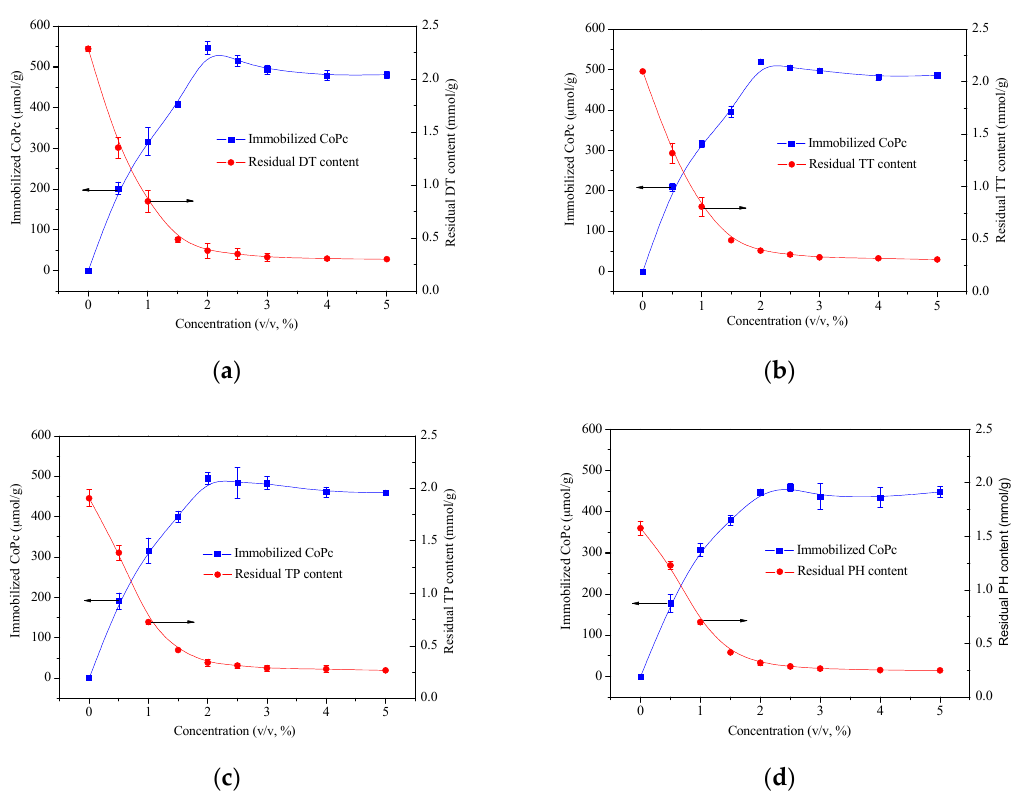
Figure 5. Effect of the glutaraldehyde concentration on the immobilized CoPc and residual spacer content for ( a ) DT-attached BC; ( b ) TT-attached BC; ( c ) TP-attached BC; and ( d ) PH-attached BC, T = 25 °C, reaction time = 2 h.